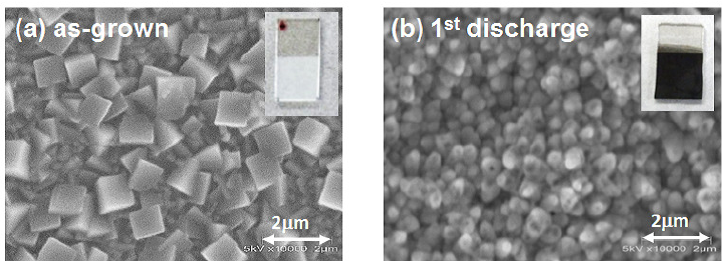
Figure 1. Scanning electron microscopy (SEM) images of ( a ) as-grown and ( b ) discharged films. Insets show pictures of the